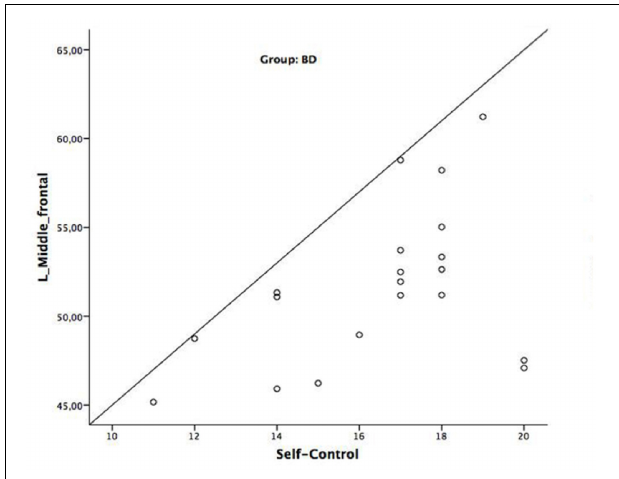
FIGURE 3 | Image shows the positive associations between brain data (GM densities) and BIS (self-control) scores in the BD